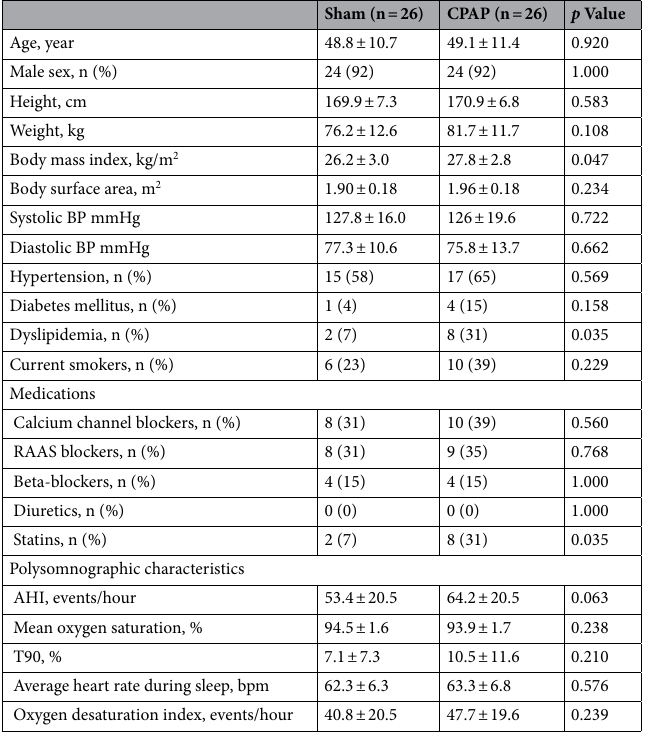
Table 1. Baseline characteristics of the study population. Values are n (%) or mean ± standard deviation. CPAP continuous positive airway pressure, AHI apnea/hypopnea index, BP blood pressure, RAAS